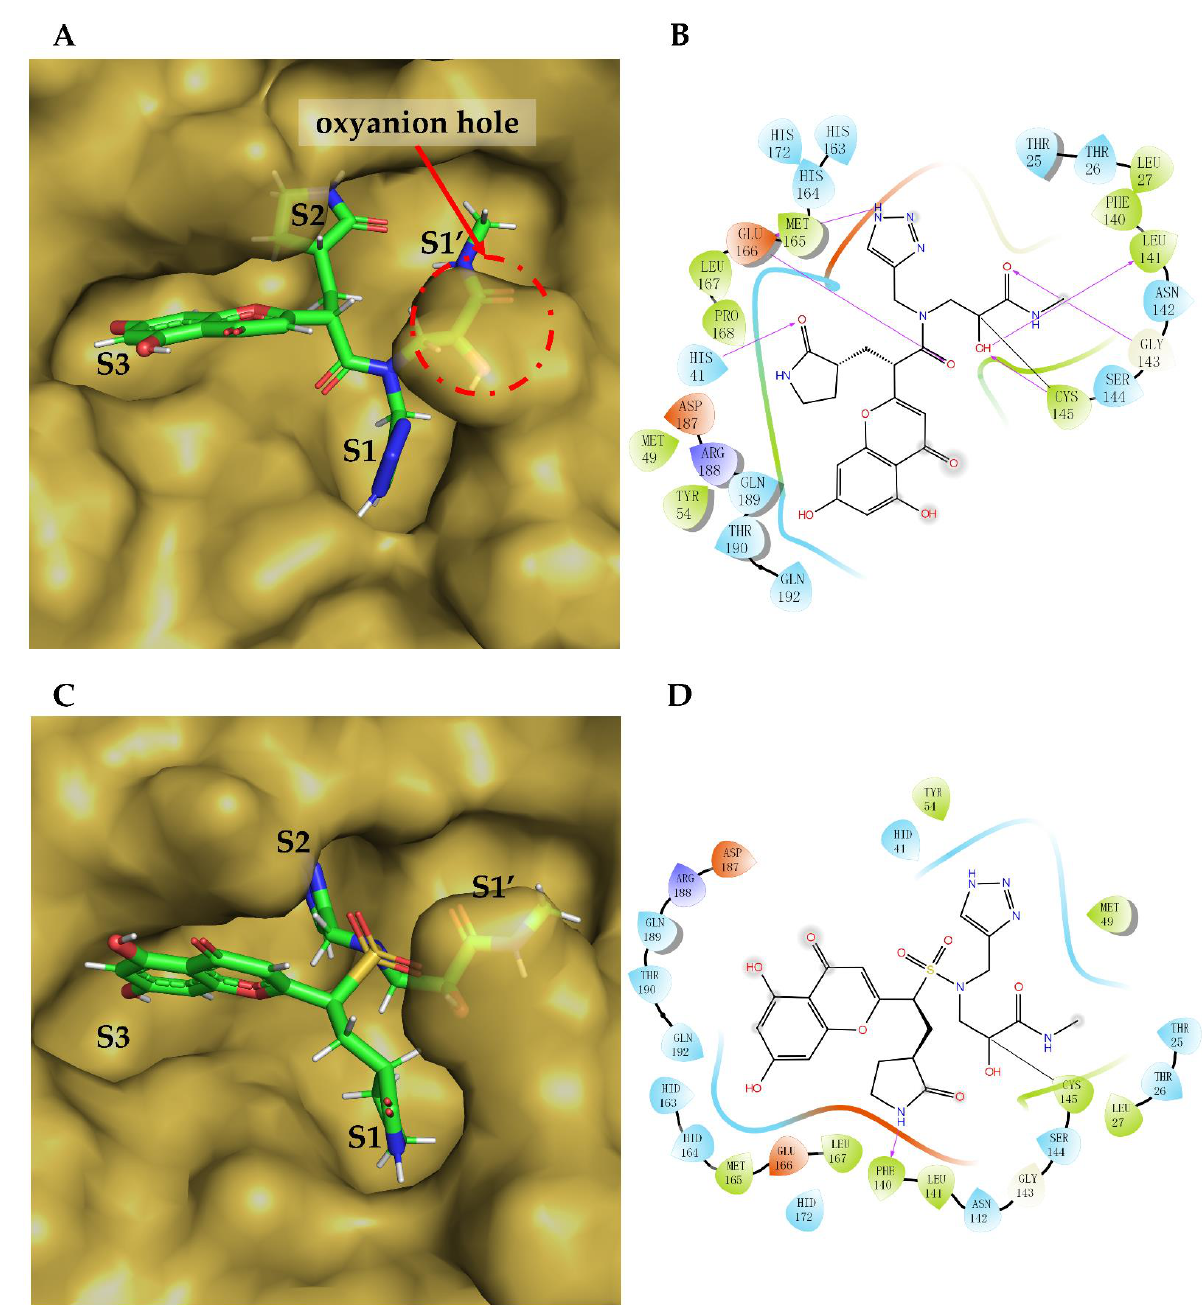
Figure 4. Co-crystal structure of the covalent adduct of ( A ) 6XHO (cyan) and ( B ) 7VH8 (magenta) bound to SARS CoV-2 3CL pro together with the alignment of ( C ) lead compound # 46 (yellow), and the detailed interactions of the complex: ( D ) 6LU7_# 46 , ( E ) 6XHO, and ( F ) 7VH8.